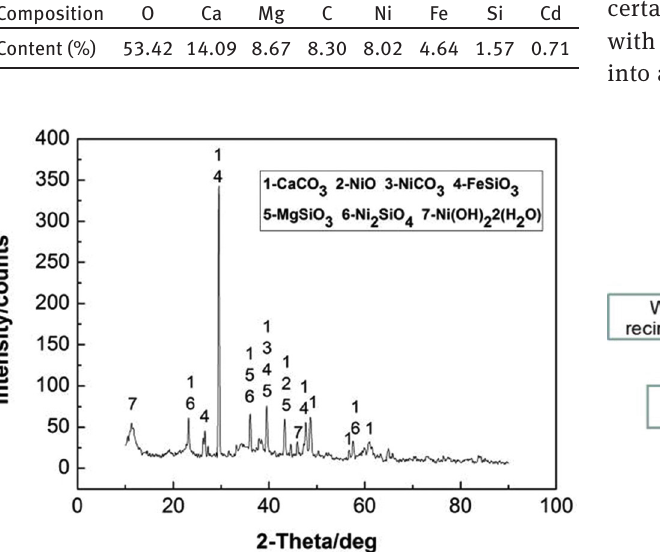
Table 1: Chemical composition of the NCR residue.